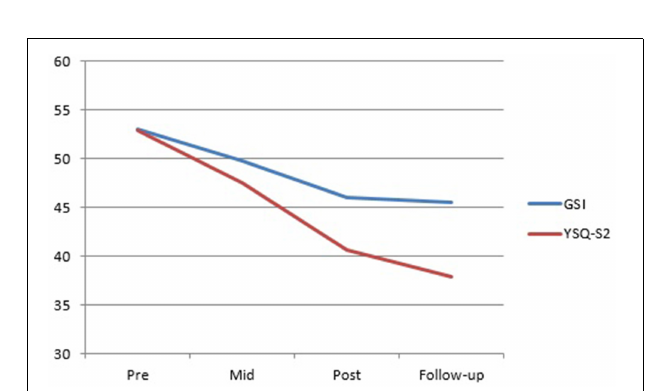
FIGURE 1 | MCMI-III Avoidant PD, Anxiety, and Depression means from pre to post-treatment, and follow-up. Scores above 85 indicate the persistent presence of personality disorder indicators.